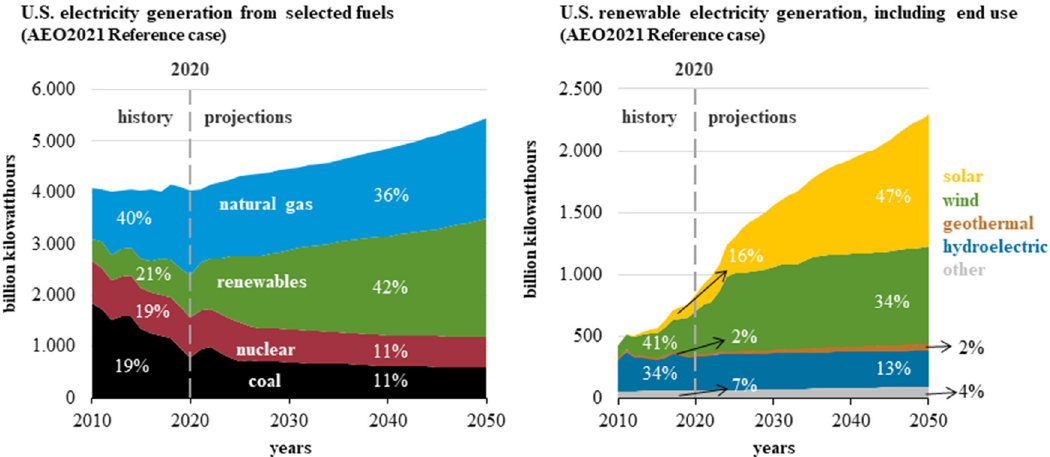
Figure 1: Electric energy production from various conventional and renewable sources in the United States in 2020, and its estimate for 2050 ( adapted from the Annual Energy Outlook 2020 ) [ 3 ] .